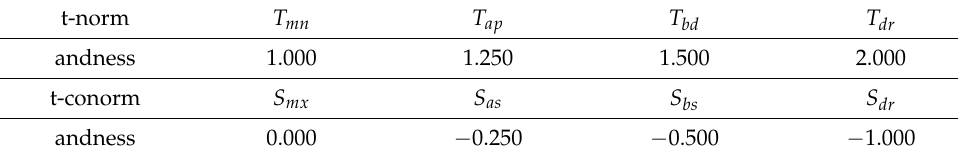
Table 1. Andness of some relevant t-norms and t-conorms.